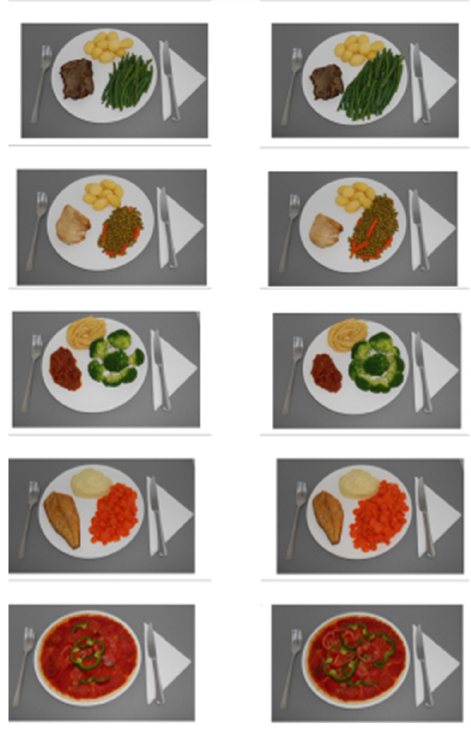
Figure 1. Meals for food choice task. The left pictures reflect meals with regular portions of meat and vegetables, and the right pictures represent meals with recommended portions of meat and vegetables.